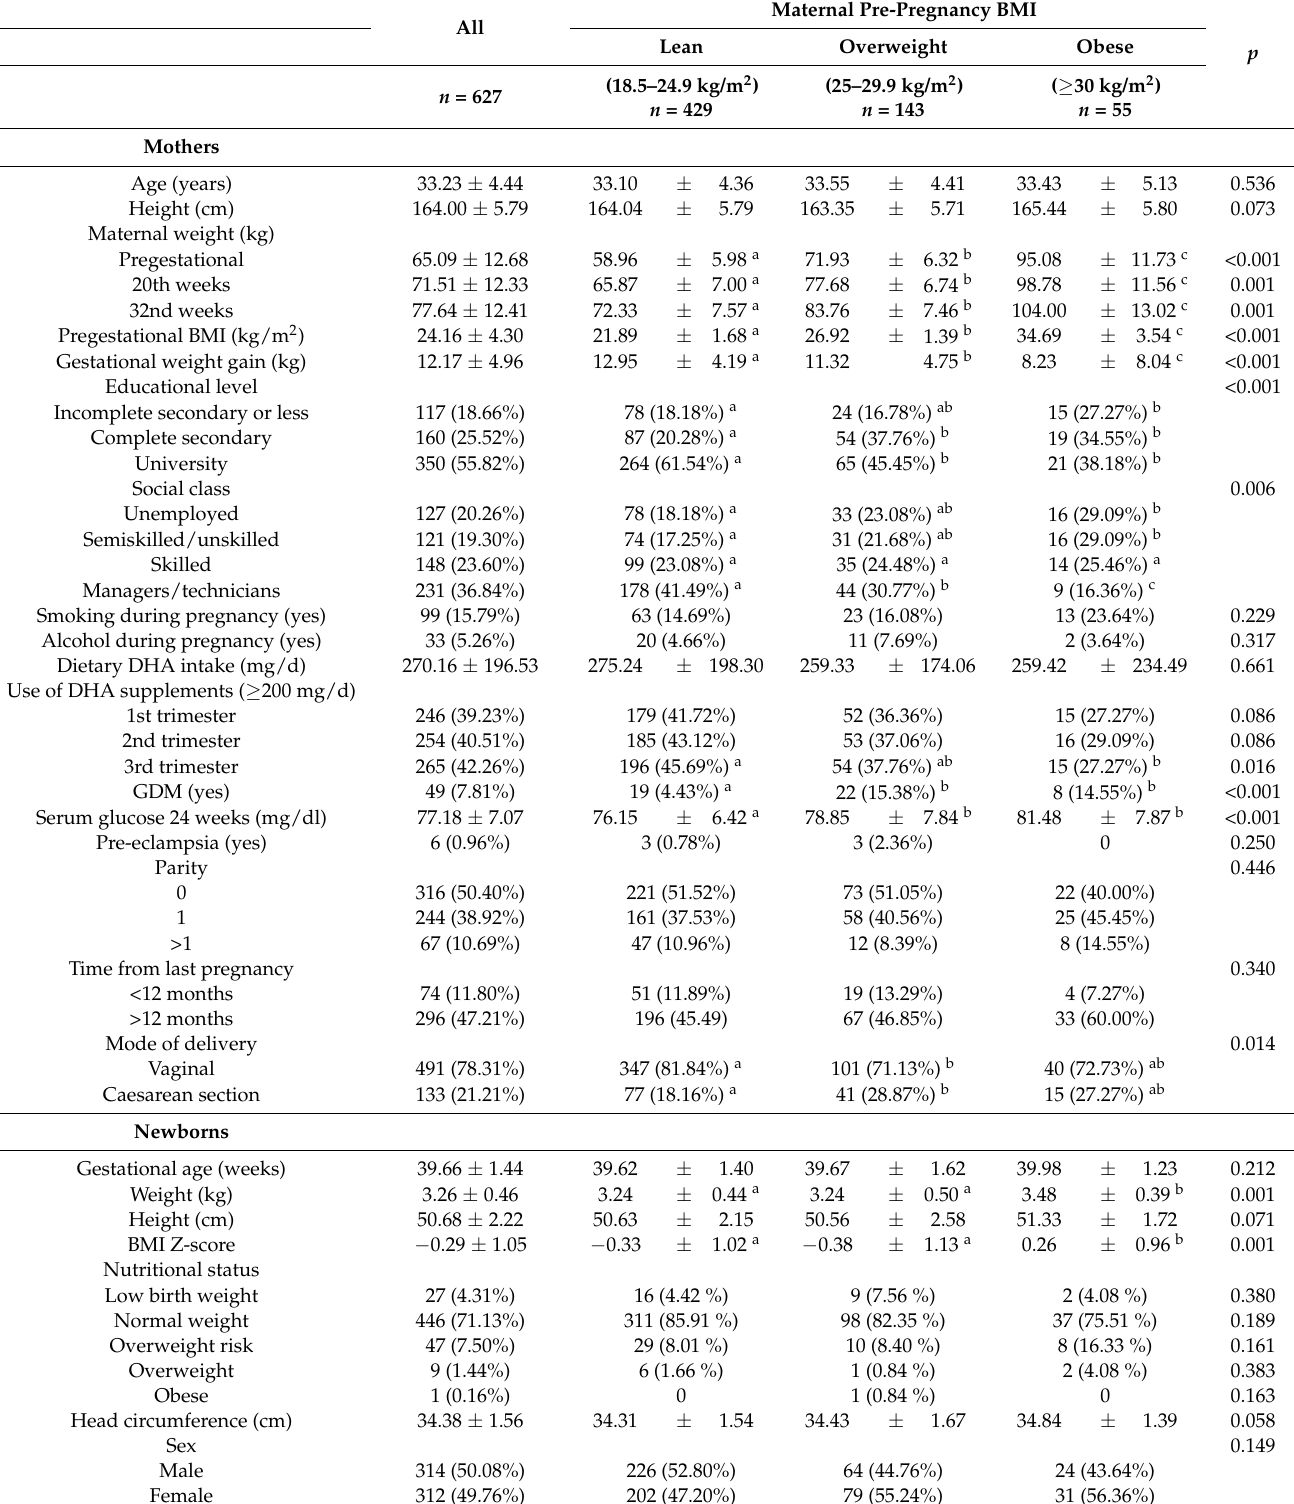
Table 1. Sociodemographic characteristics of participants categorized by maternal pre-pregnancy body mass index (BMI). The Nutrition in Early Life and Asthma (NELA) study